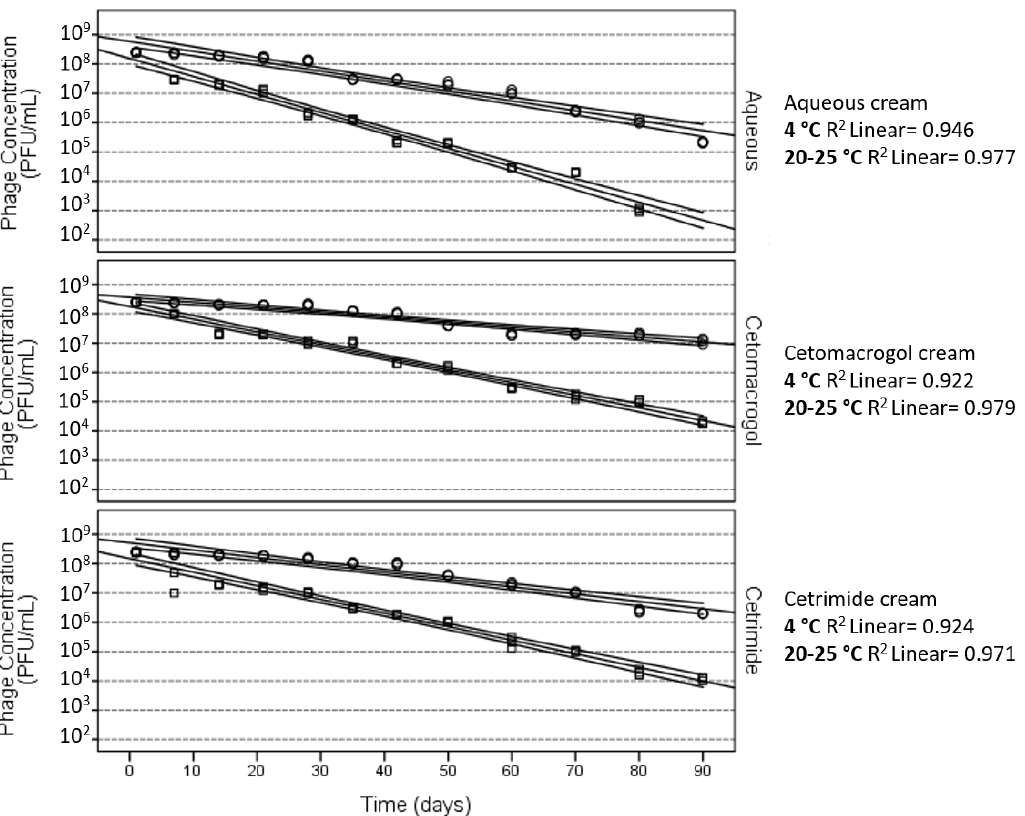
Figure 2. P. acnes phage PAC1 stability in semi-solid dosage forms. These regression plots show 4 °C (as depicted by the circles) and 20 – 25 °C (as depicted by the squares) treatments for each cream type. The central lines in each plot are the regression best fit lines and the curved lines define 99% confidence bounds. For P. acnes phage PAC1 cetomacrogol was the optimal semi-solid preparation tested [31].